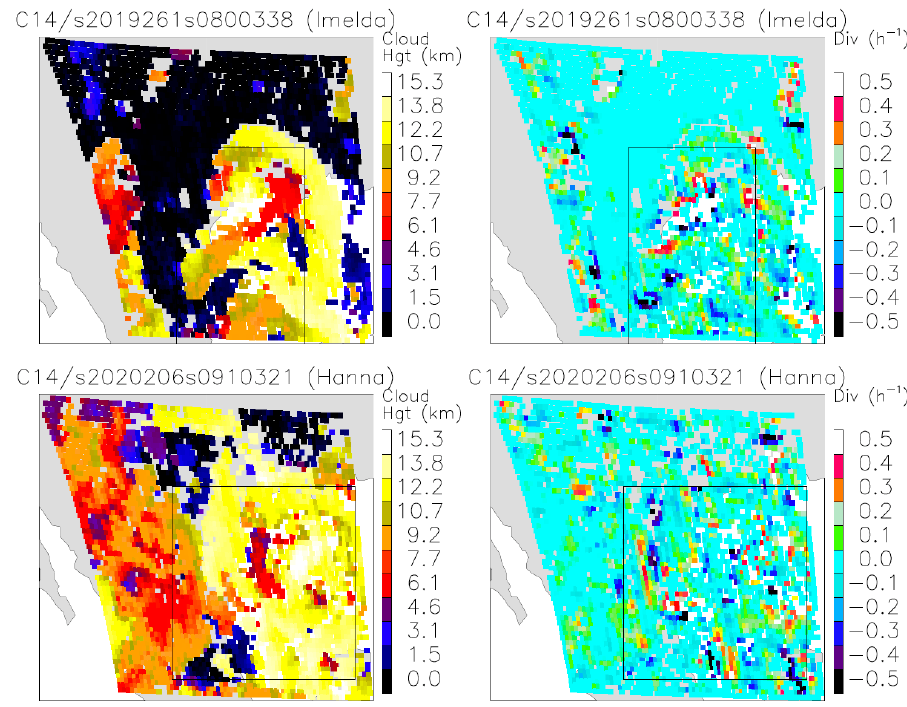
Figure 16. A snapshot of Tropical Storm Imelda (2019) and Hurricane Hanna (2020) cloud height ( left panels ) and cloud top (>10 km) divergence ( right panels ) retrieved from B14. The stereo-wind retrievals are made from the CONUS-FD pairing with 10-min sampling. The box in each case indicates the region of interest for comparison with the domain-average precipitation data. For Imelda, the box area is (110° W–98° W, 32° N–38° N) and for Hanna it is (110° W–100° W, 30° N–35° N).